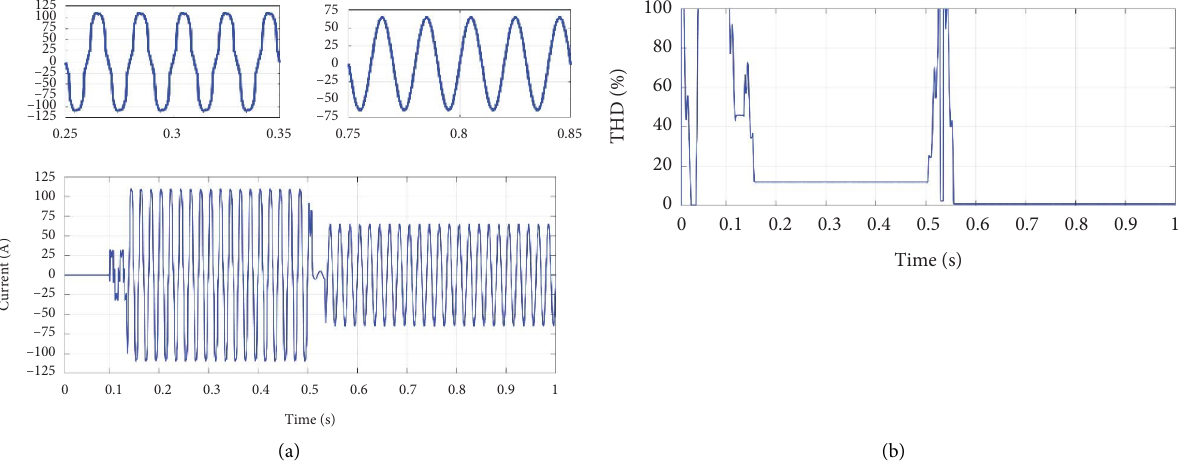
Figure 9: Filter current injected by PV system (a) and its THD (b).